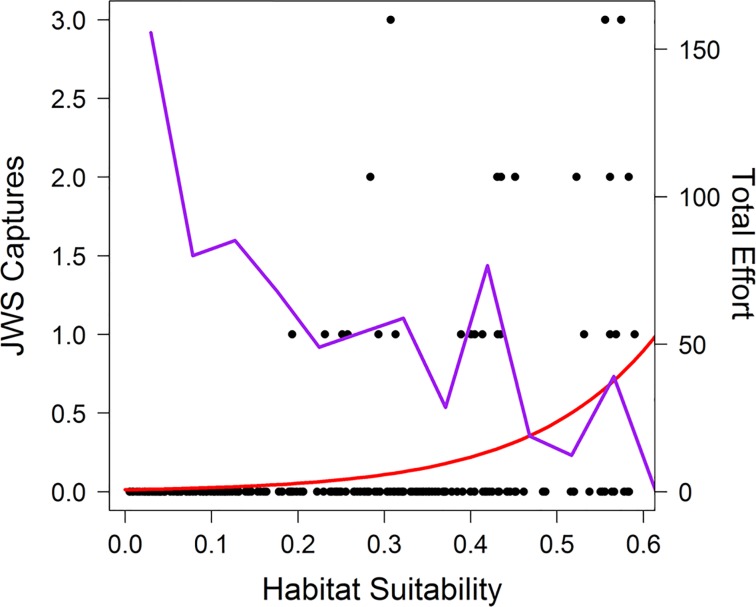
JWS captures by predicted suitability.The number of JWS captured (black circles) in each block-month (left y- axis) against the predicted habitat suitability. Habitat suitability predicted the mean number of JWS caught (red line). Sum total effort (right y-axis, Hours/fathom length) across habitat suitability (purple line) is overlaid, and decreases with increasing habitat suitability.